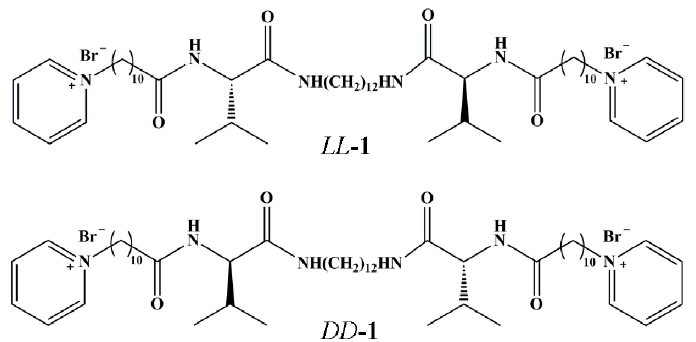
Figure 1. Molecular structures of gelators LL - 1 and DD - 1 .